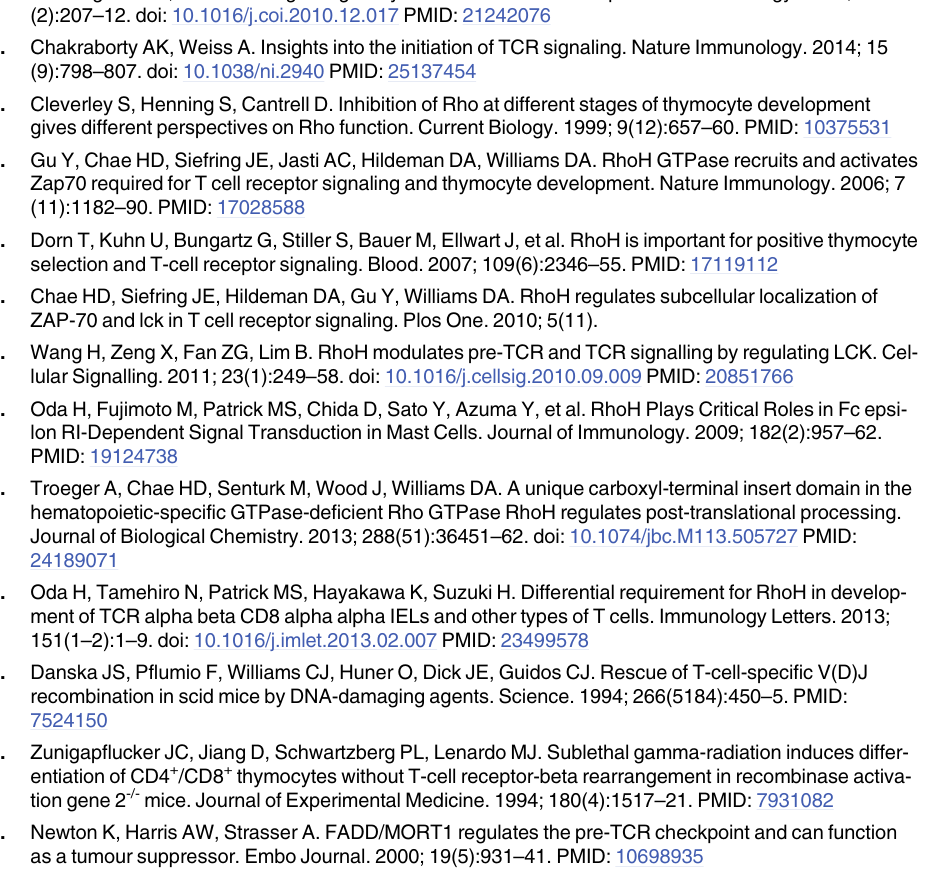
S4 Fig. Analysis of the effect of RhoH transgene on peripheral lymphcytes. S5 Fig. The effect of RhoH transgene on Rag2-deficient thymocytes. S6 Fig. The inhibition of in vitro thymocytes differentiation with LCK